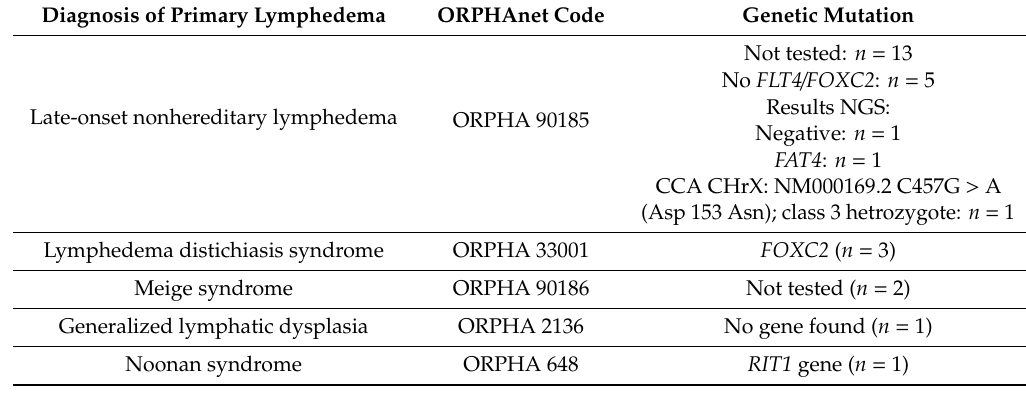
Table 1. Diagnosis of primary lymphedema and eventually corresponding gene